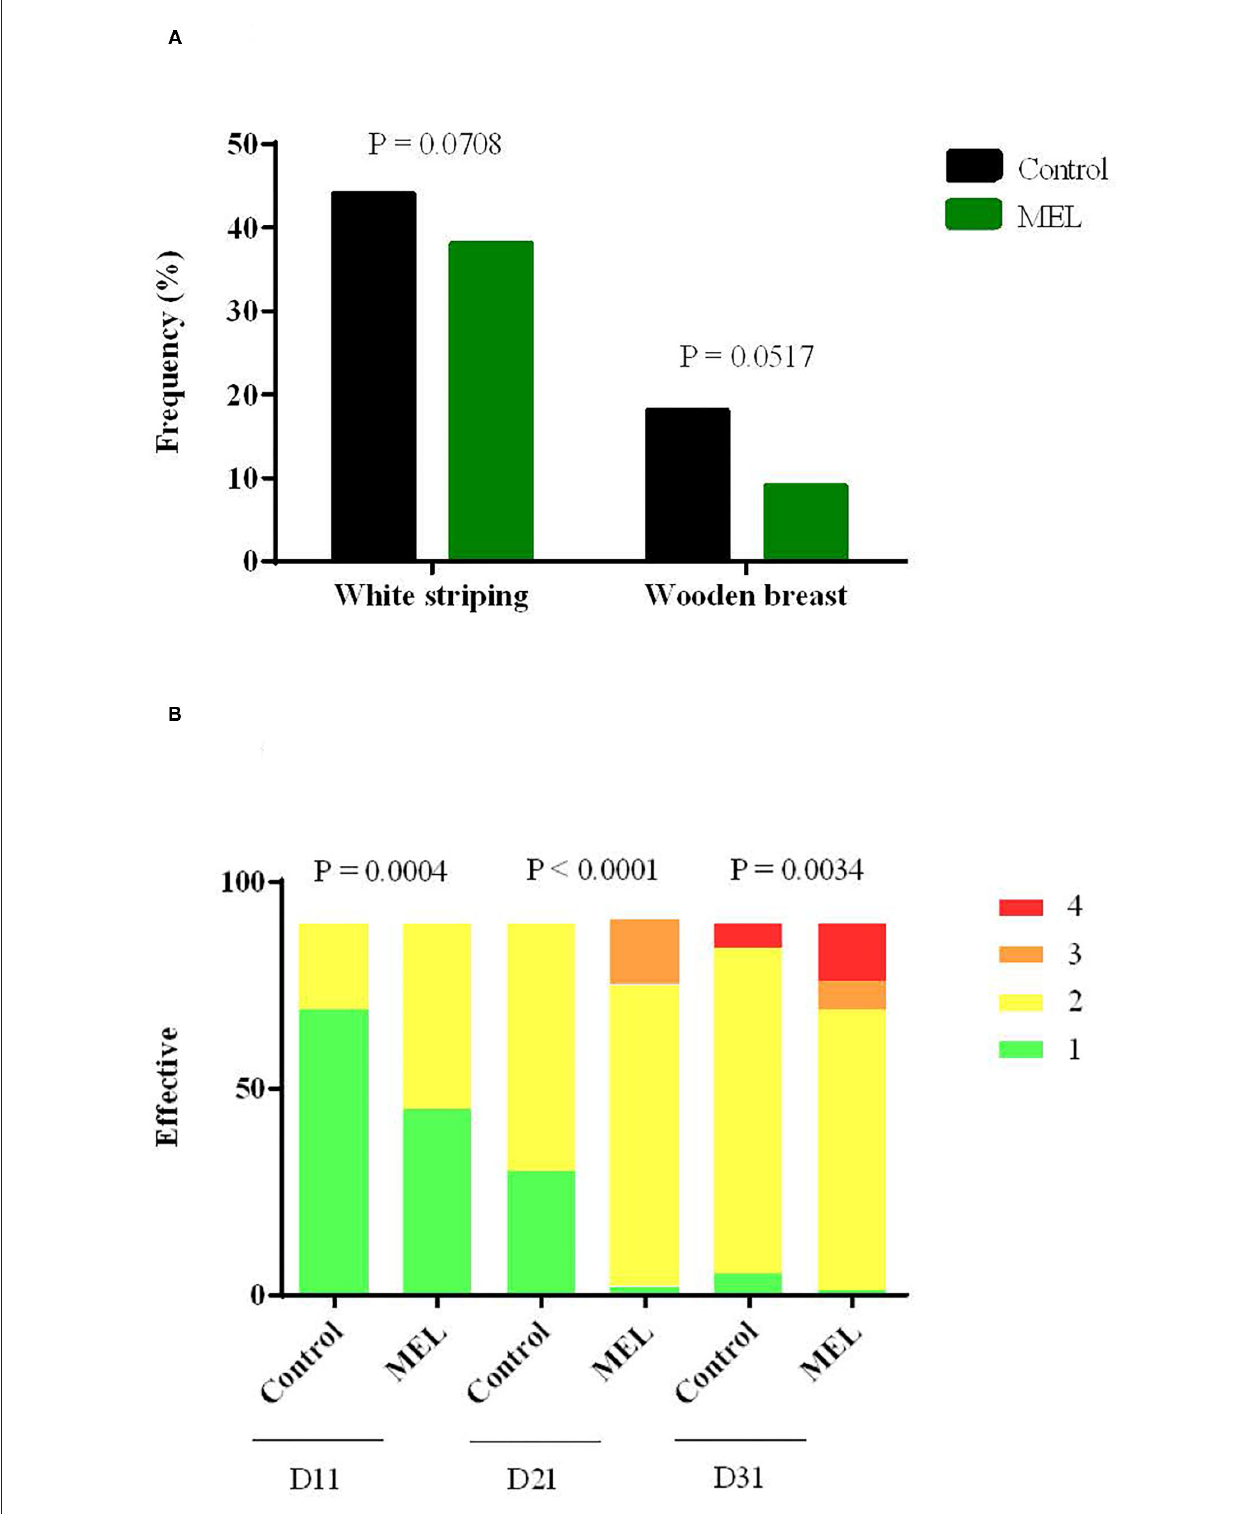
FIGURE 4 | Effects of MEL extract supplementation on muscle defect frequency such as white striping and wooden breast at slaughter age (A) and on the severity of lesions for pododermatitis (B) at 11, 21, 31 days of age. Data represent the number of animals for each of the muscular defects ( n = 100) and scores attributed to pododermatitis ( n = 90), between control and MEL groups (Chi-square